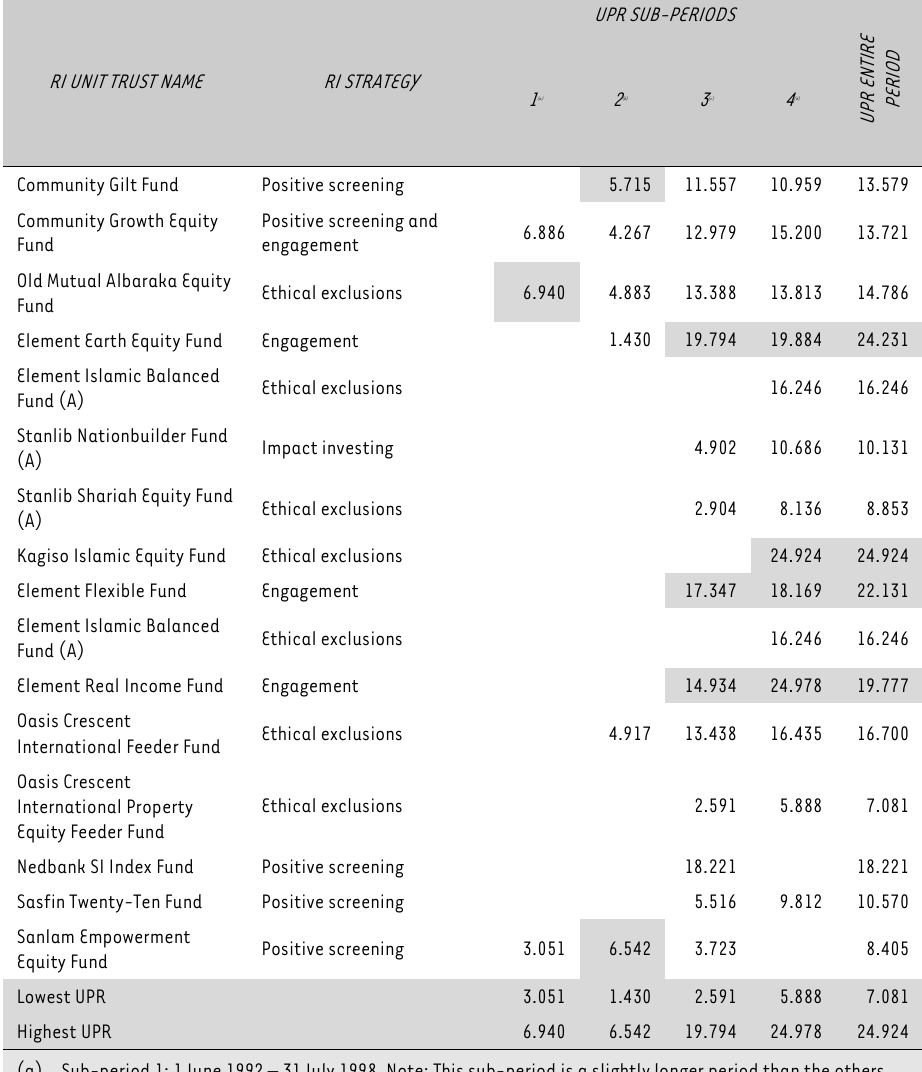
TABLE 9: Upside-potential ratios of RI unit trusts over sub-periods